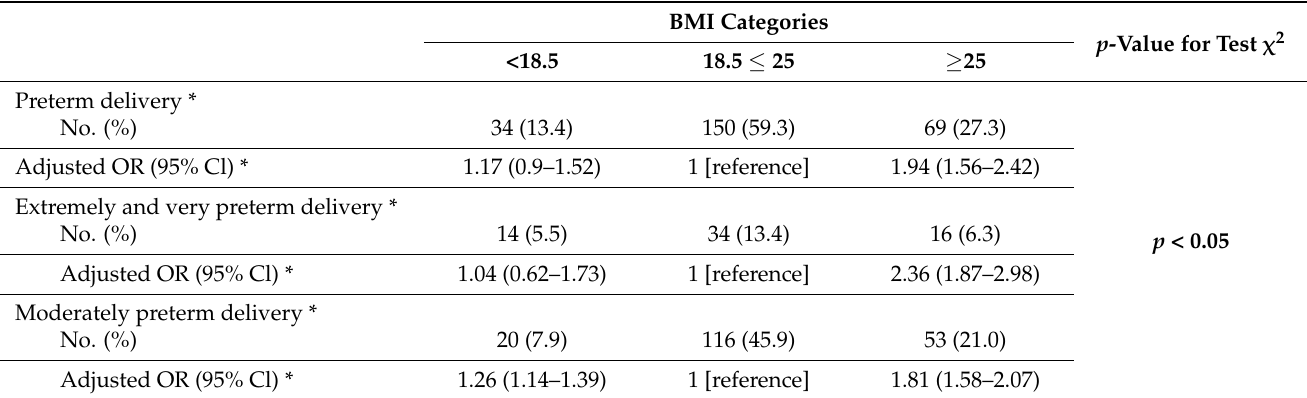
Table 4. Logistic regression results for maternal BMI in early pregnancy and risks of preterm delivery (n = 2